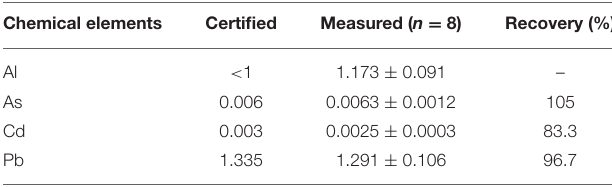
TABLE 2 | Analysis of NIST-SRM 1486 (National Institute of Standards and Technology-Standard Reference Material) bone meal (mg/kg dry weight). Chemical